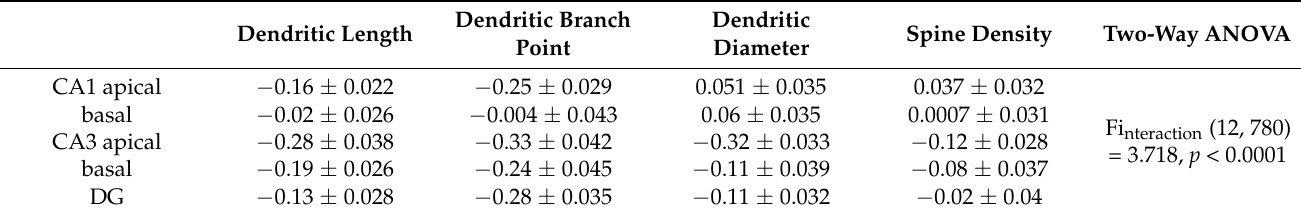
Table 5. Results of two-way ANOVA tests for the effects of the hippocampal subregion and morphological parameters on log2 fold changes in KO mice relative to WT mice.